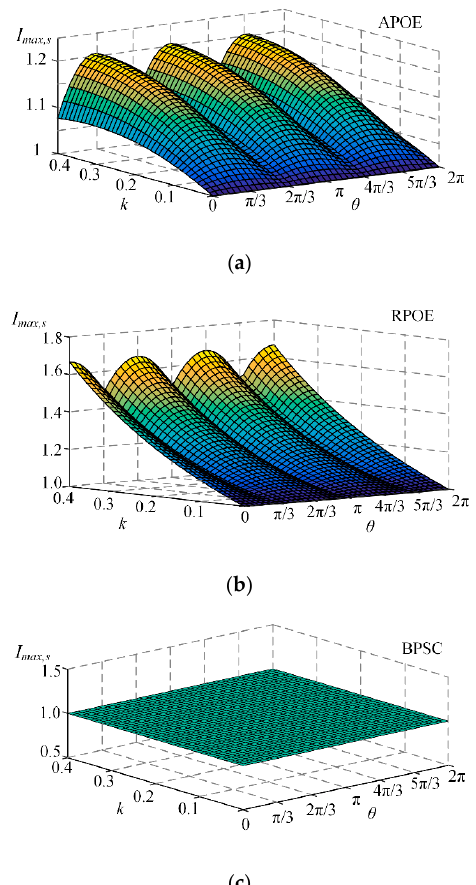
Figure 8. Relationships among the maximum current amplitude, unbalanced factor and the phase angle of the negative sequence voltage. ( a ) APOE. ( b ) RPOE. ( c ) BPSC. angle of the negative sequence voltage. ( a ) APOE. ( b ) RPOE. ( c ) BPSC.